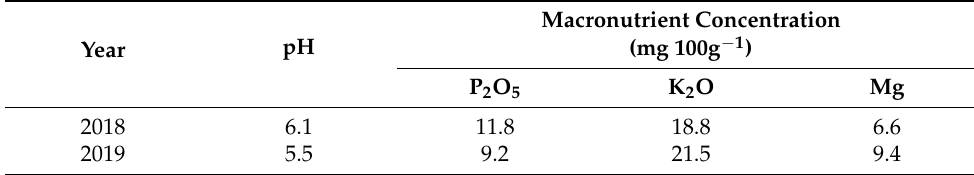
Table 1. Soil properties in years of research (pH and content of macronutrients).